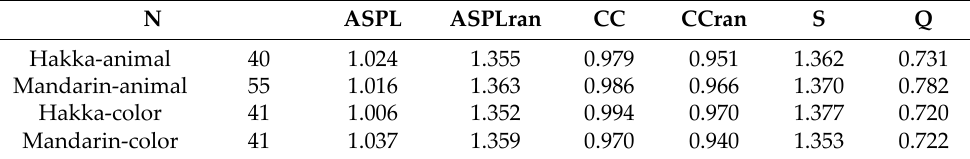
Table 1. Lexical network parameters. N ASPL ASPLran CC CCran S Q